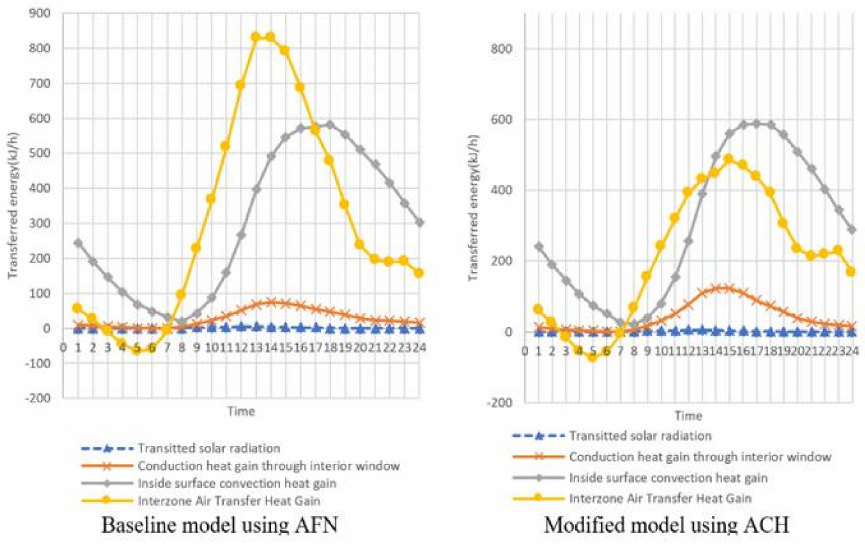
Figure 6. Types of heat transfer on cooling design